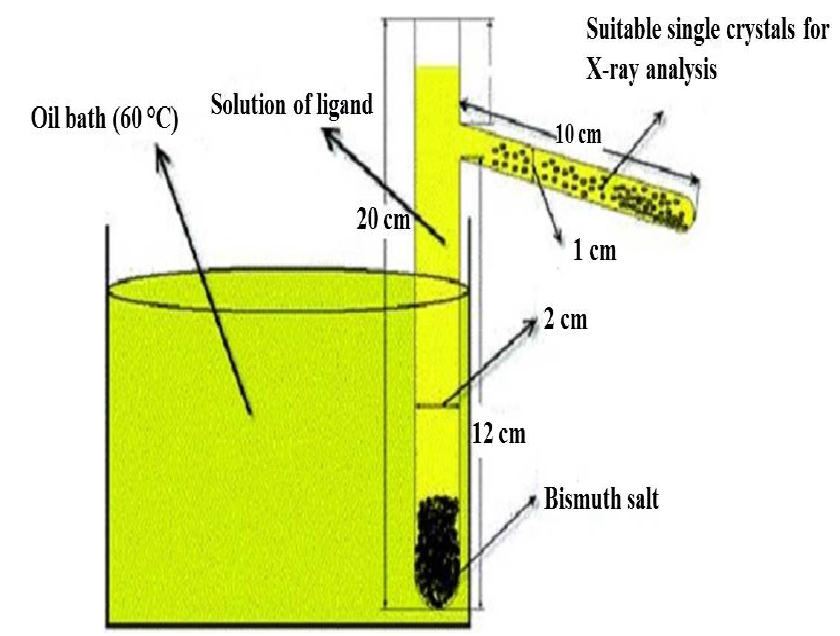
Figure 1. Branched tube